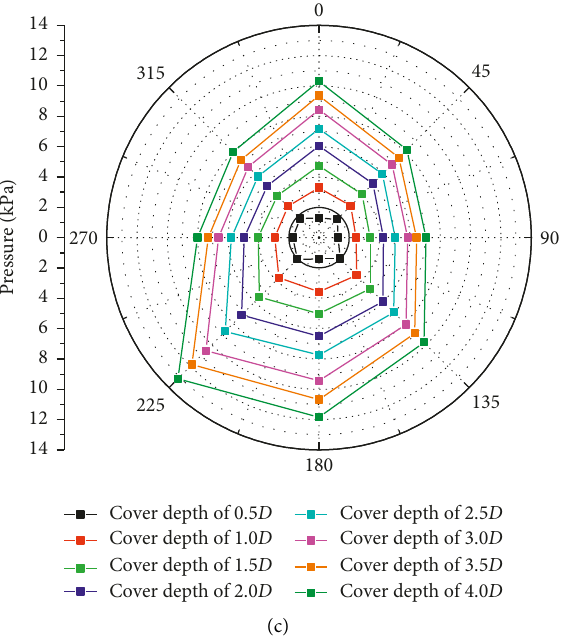
Figure 12: Earth pressures acting at different locations around the tunnel rings under the realistic loading conditions. (a) Straight-jointed ring. (b) Stagger-jointed ring. (c) Uniform